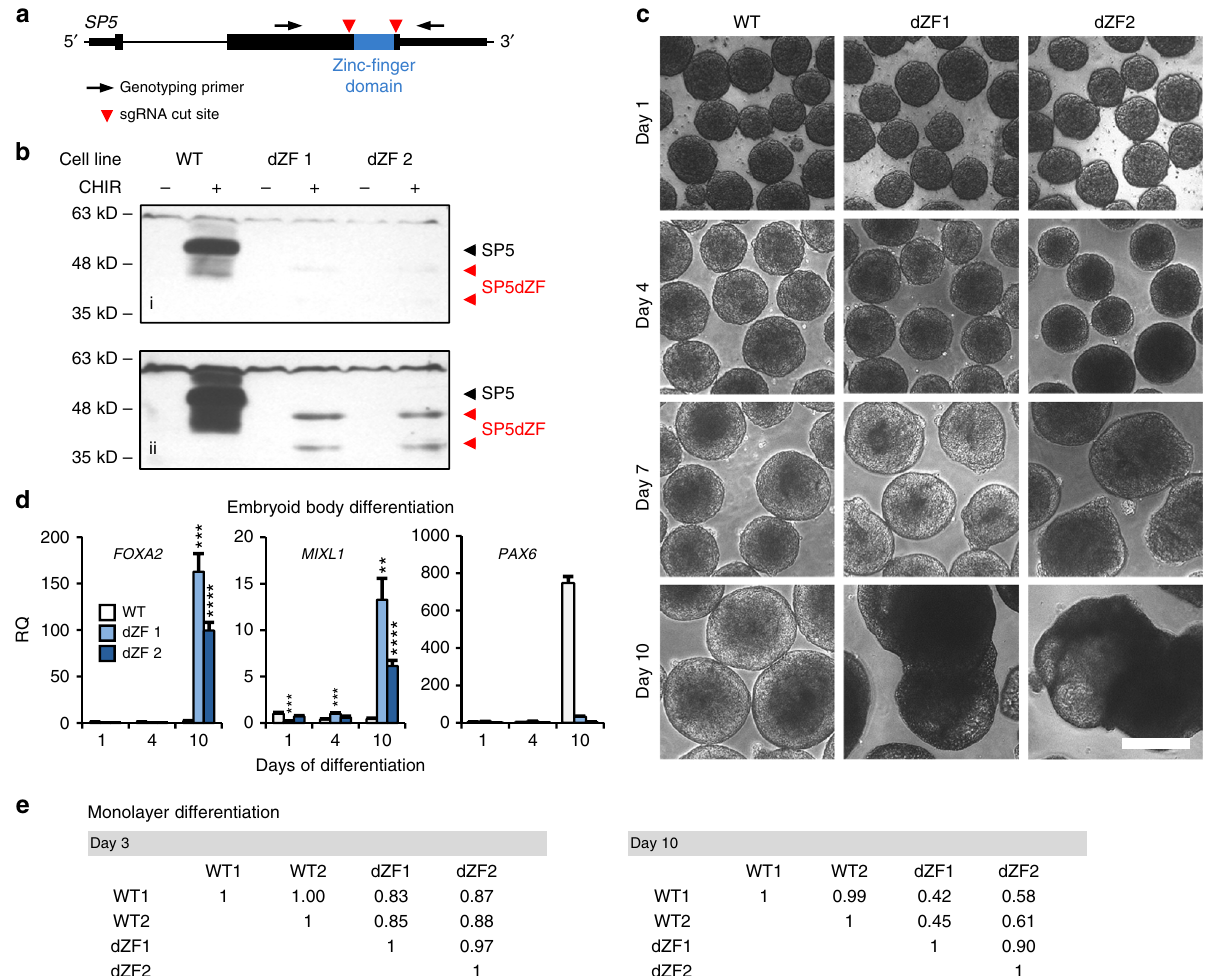
Fig. 2 SP5 is required for normal hPSC differentiation. a Schematic of the SP5 gene. A deletion of the sequence encoding the C2H2 Zinc- fi nger DNA binding domain was generated using CRISPR-Cas9 with two guide RNAs (designated by red arrowheads). Gene structure: thin lines for intron and intergenic regions, medium lines for non-coding exonic sequence, and thick lines for open reading frame. The position of genotyping primers is indicated by arrows. b Wild-type and mutant SP5 protein detection. Lysates from unstimulated ( − ) and CHIR-stimulated (+) WT and SP5 mutant (dZF1 and 2) hESCs were analyzed by immunoblotting. Short (i) and long (ii) exposures of the same immunoblot are shown. CHIR = CHIR98014; kD kilo Daltons. c Altered EB formation from SP5 mutant cell lines. SP5 mutant EBs acquire abnormal morphologies at later time points. Scale bar = 100 μ m. d Altered gene expression in SP5 mutant EBs. RNA was isolated from EBs at the indicated days after initiation of differentiation and analyzed by qPCR for expression of markers indicative of endoderm ( FOXA2 ), mesoderm ( MIXL1 ), and ectoderm ( PAX6 ). RQ relative quantity. (Error bars are SEM for four technical replicates; Student ’ s t test: ** p < 0.01; *** p < 0.001; **** p < 0.0001). e Altered gene expression in monolayer differentiation of SP5 mutant cells. WT and SP5 mutant (dZF 1 and 2) hESCs were differentiated through removal of FGF2 and addition of fetal bovine serum. RNA was extracted at 3 and 10 days after initiation of differentiation and analyzed by RNA-Seq. Correlation matrices representing 5253 differentially expressed genes indicate increased divergence of WT (two independent differentiations) and dZF cells at days 3 and 10 of